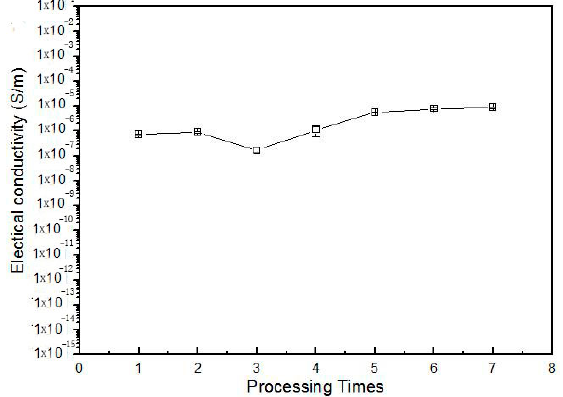
Figure 7. Variation of electrical conductivity for PPS/PEEK/MWCNT nanocomposites containing 1 wt % MWCNT prepared via methods C with repetition of the injection molding process.